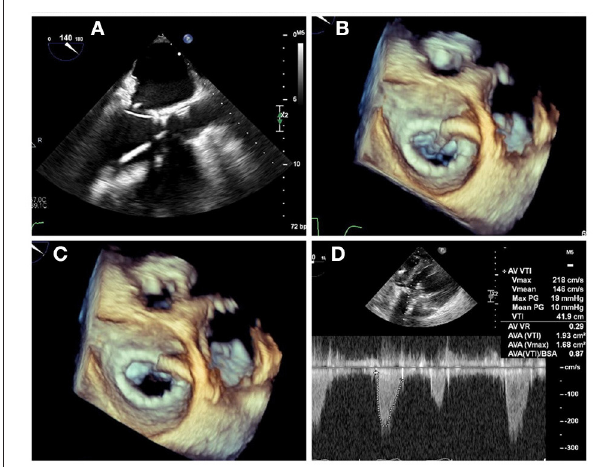
FIGURE 9 | LAMPOON procedure during TMVR. In cases of anticipated LVOT obstruction, intentional laceration of the anterior mitral valve leaflet (LAMPOON procedure) can be performed by connecting a retrograde wire through the aortic valve and an antegrade transseptal wire from the LA to form a loop via snaring (A) . The loop is positioned in the trajectory to transect the A2 scallop (B) , and tension is applied during radiofrequency energy application to lacerate the anterior leaflet from base to tip (C) . In this case, post-valve-in-ring implantation measurement demonstrated a mean gradient across the LVOT of 10mm Hg (D)